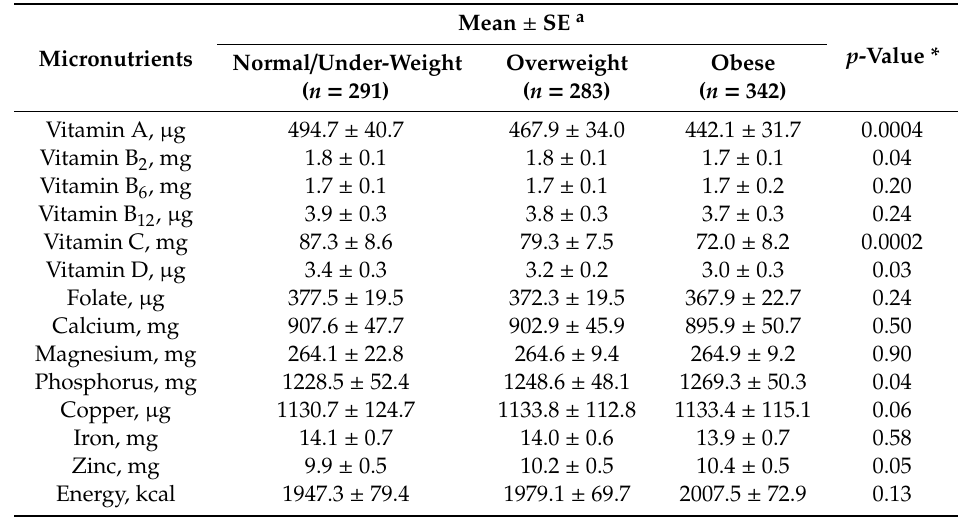
Table 3. Estimated daily usual micronutrient intakes from foods, and micronutrient density among Mexican American women aged 19–39 years old by body weight status, NHANES 2003–2014 ( n =